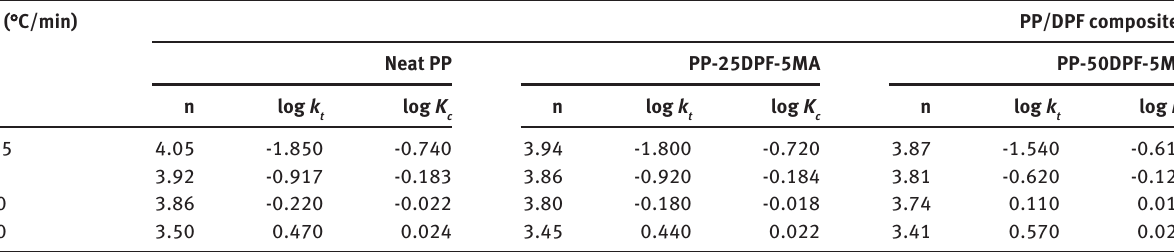
Figure 4: Plots of log [-ln (1- X ( t ))] vs. log (t) for crystallization of (A) neat polypropylene (PP), (B) PP-25 date palm fiber (DPF)-5MA and (C) PP-50DPF-5MA composite materials at various cooling rates. Table 2: Parameters obtained from Avrami analysis and Jeziorny corrected constants for neat polypropylene (PP) and PP-DPF composites at different cooling